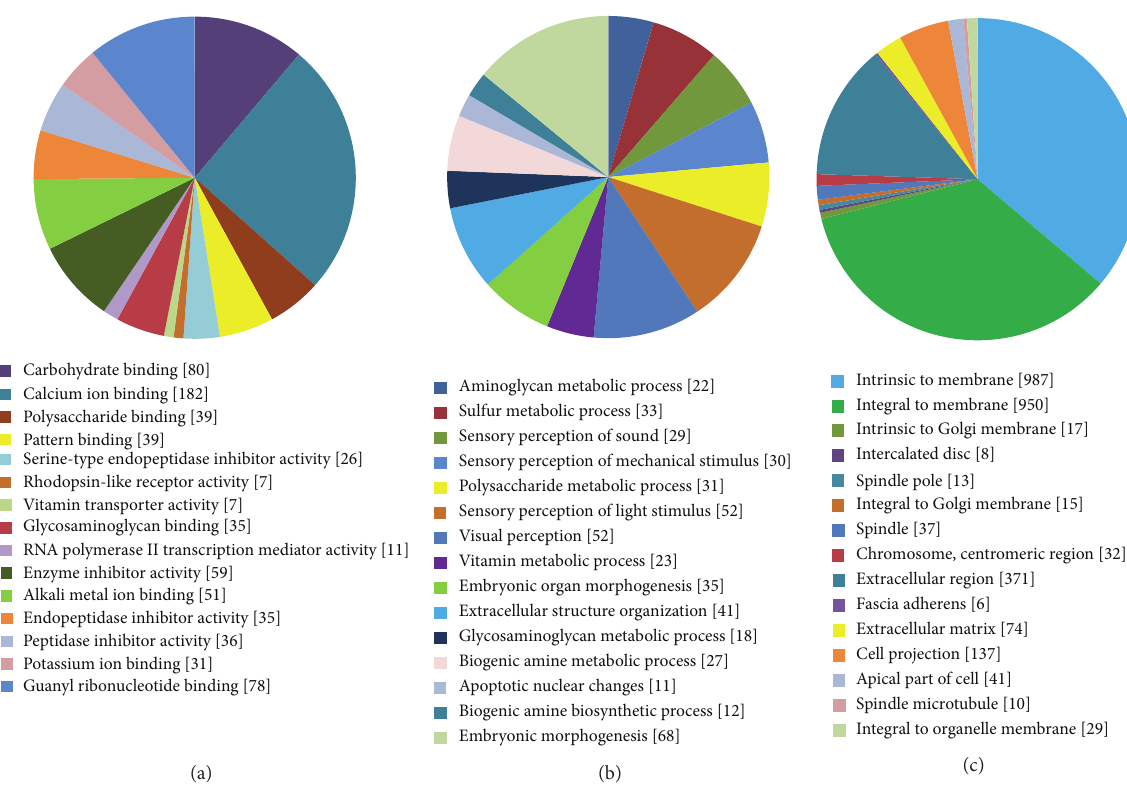
Figure 1: The top 15 enriched GO terms of DEGs. (a) Molecular functions for DEGs ( 𝑃 value ≤ 4.61𝐸 − 03 ); (b) biological process for DEGs ( 𝑃 value ≤ 6.54𝐸 − 03 ); (c) cellular component for DEGs ( 𝑃 value ≤ 1.95𝐸 − 03 ).